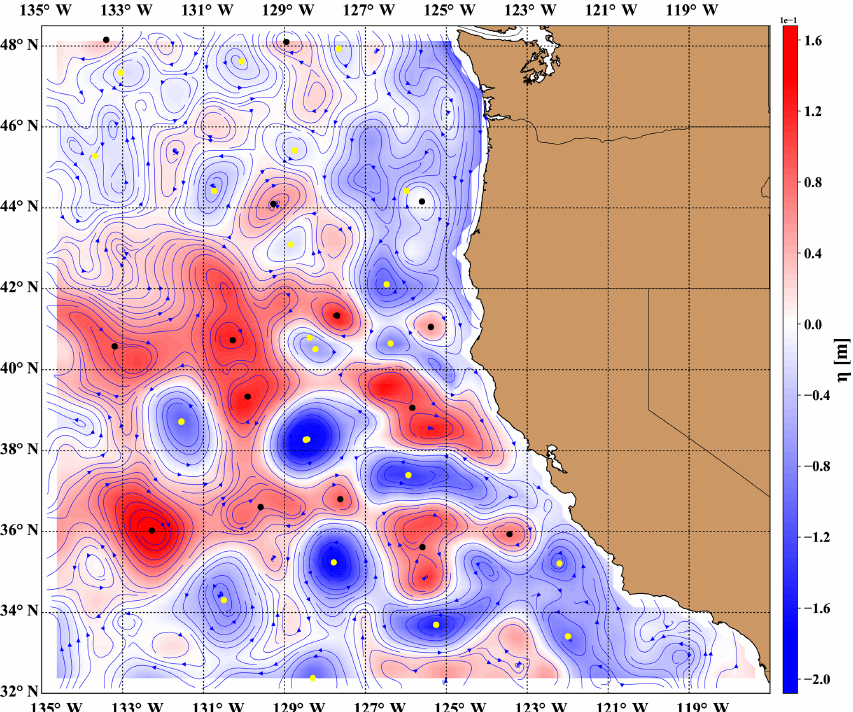
Figure 1. Visualization of the geostrophic flow field on a randomly chosen day (13 October 2013) from the data set over the US west coast by Risien and Strub (2016). Sea level anomalies ( η ) are color coded; blue stream lines indicate flow directions. The centers of cyclonic (yellow dots) and anticyclonic (black dots) eddies are determined by a standard algorithm (Chelton et al.,